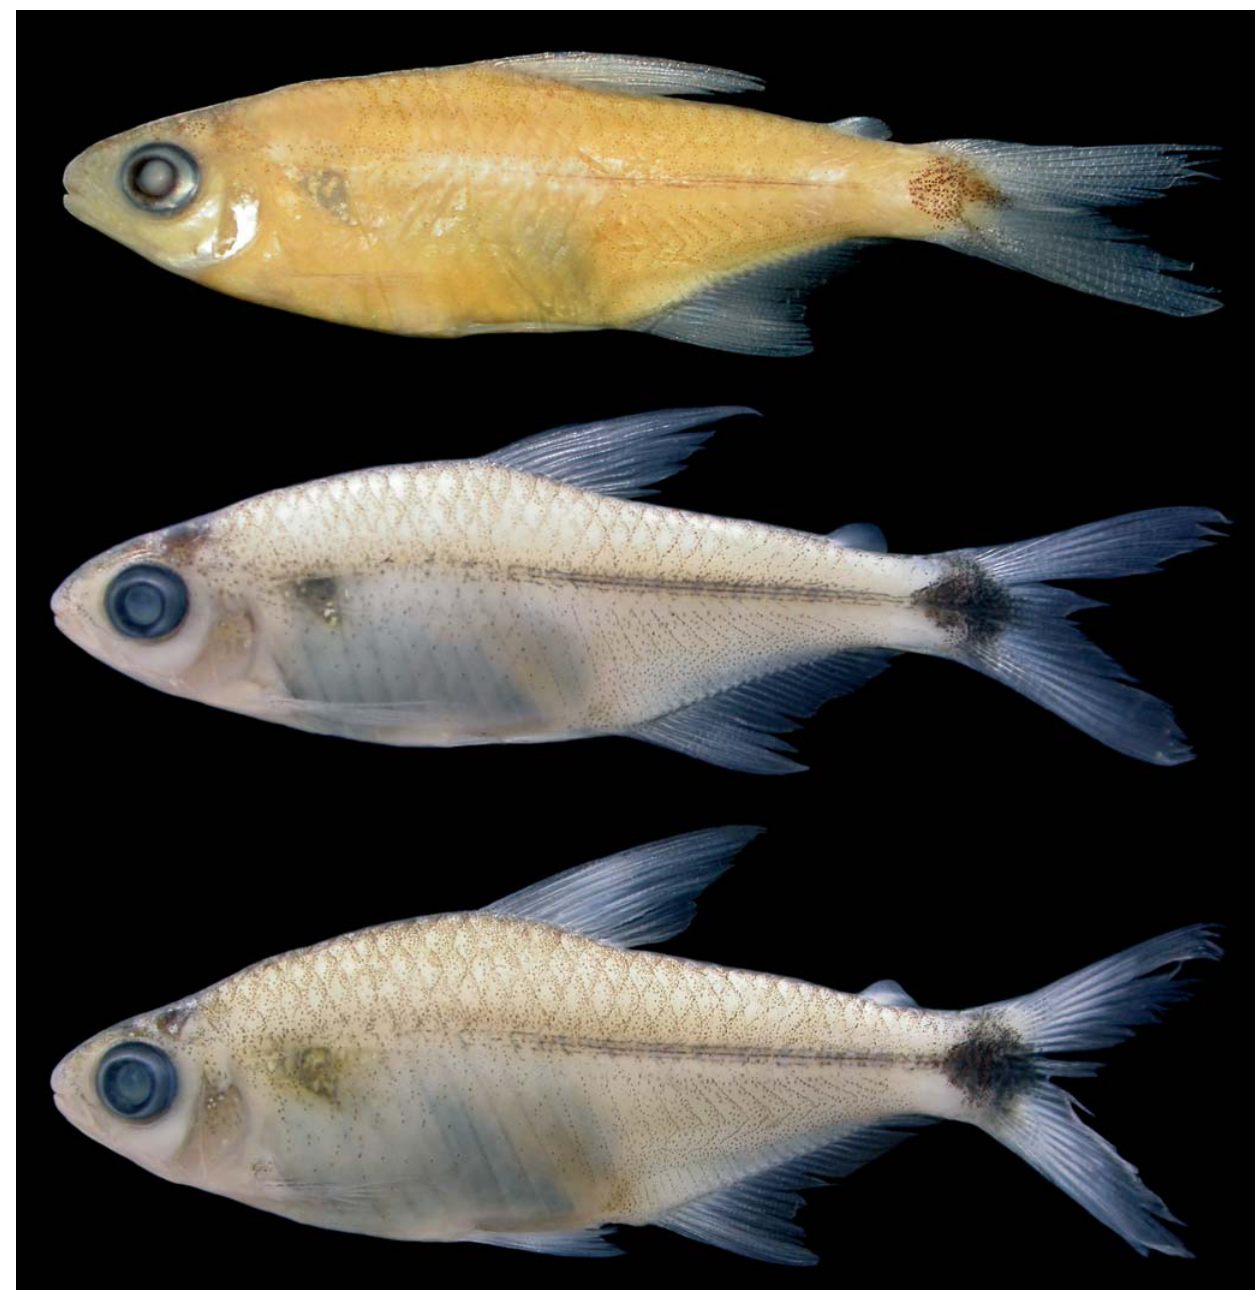
Fig. 24. Holotype of Odontostilbe parecis , INPA 24885, male 33.0 mm SL (top), and paratypes MCP 37319, male 33.0 mm SL (middle), female 41.6 mm SL